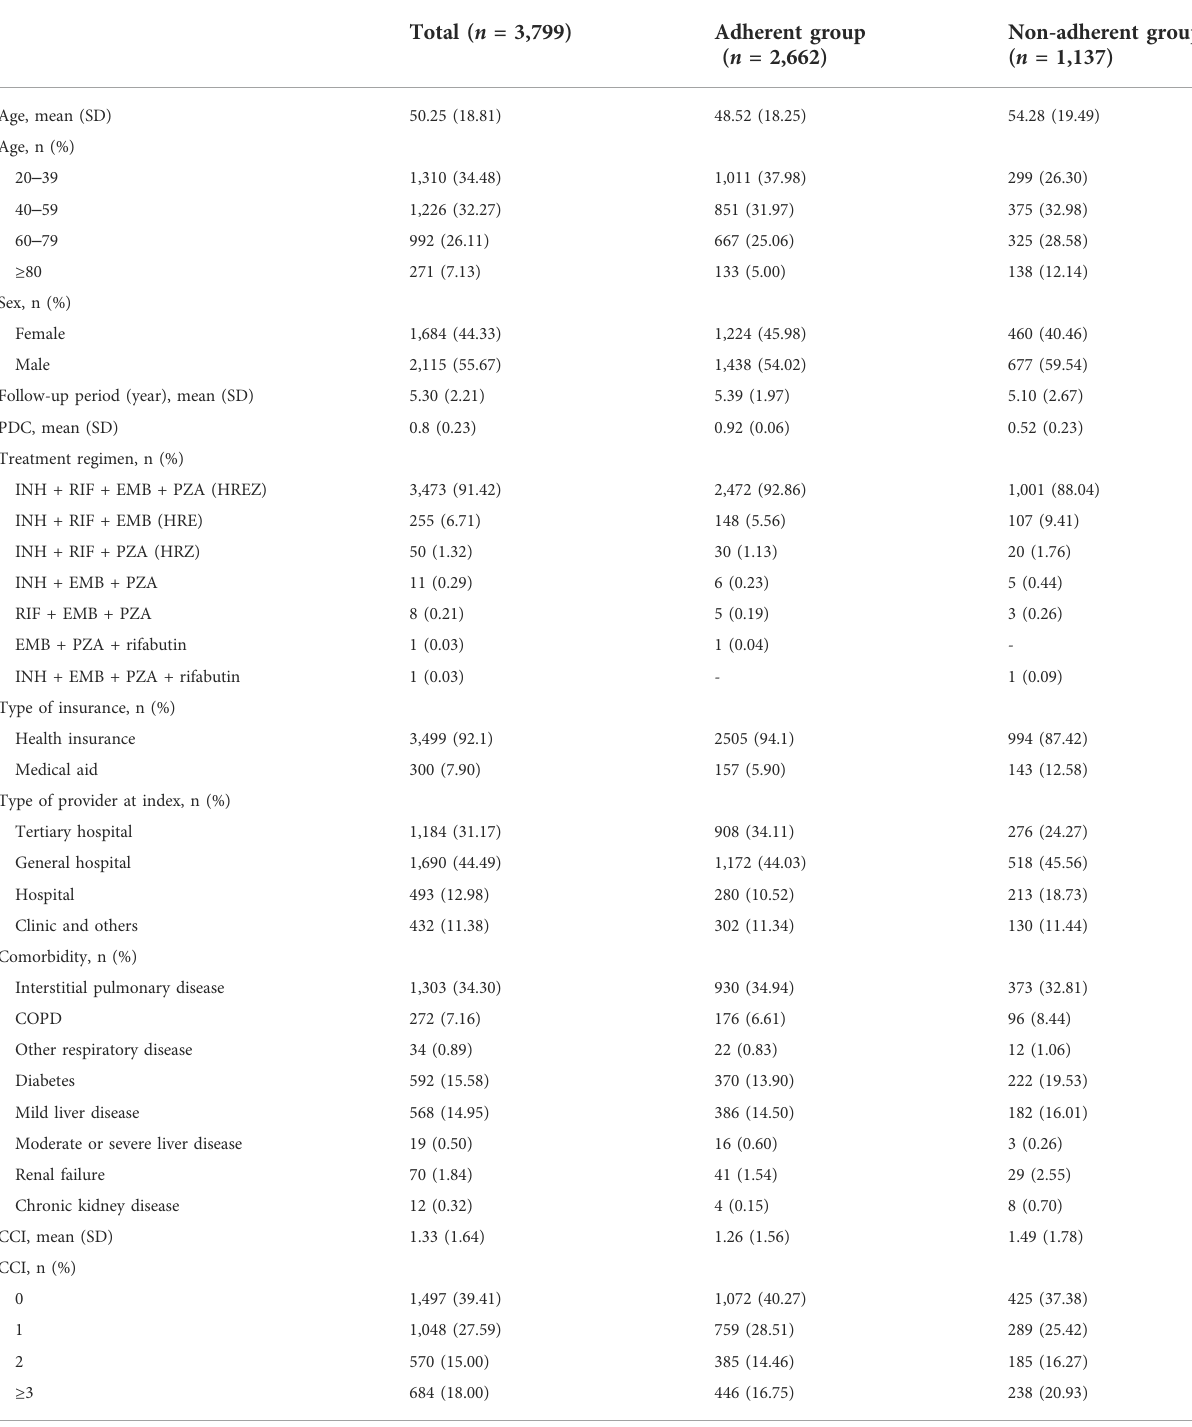
TABLE 1 Baseline characteristics according to